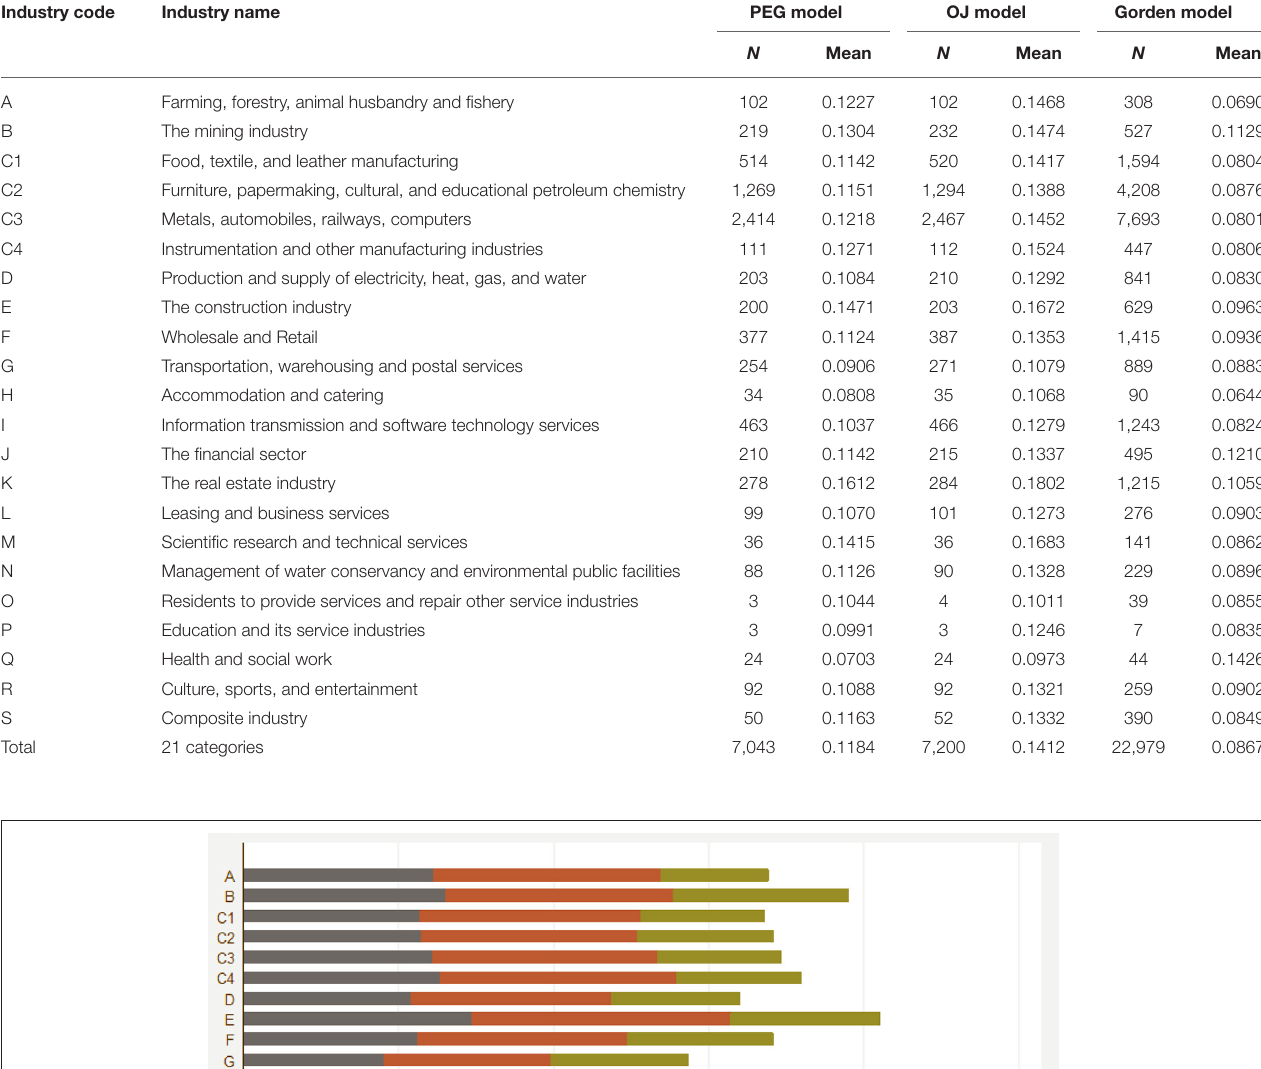
TABLE 3 | The mean value of equity cost by industry from 2005 to 2018. Industry code